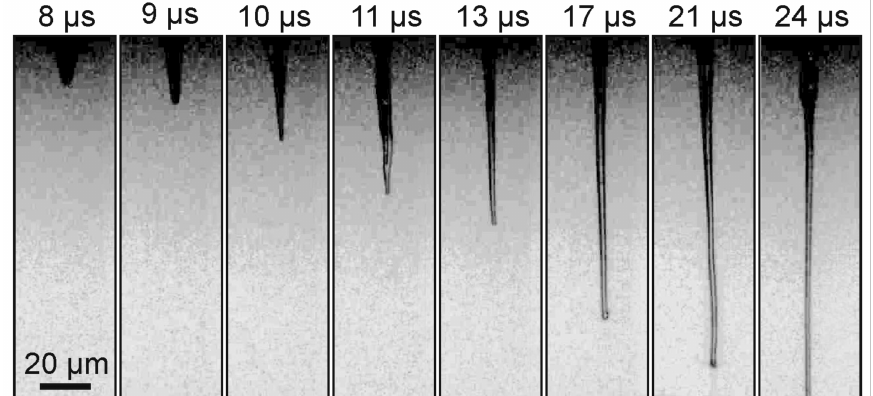
Figure 3. A sequence of frames obtained using time-resolved shadow microscopy during the generation of a vapor–gas bubble and a jet of gel (2% hyaluronic acid—see Methods) under the laser pulse impact with a duration of τ = 8 ns and an energy of E = 30 µ J on the absorbing Ti layer in Configuration 1 (Figure 1A). Each frame shows the time after exposure to the laser